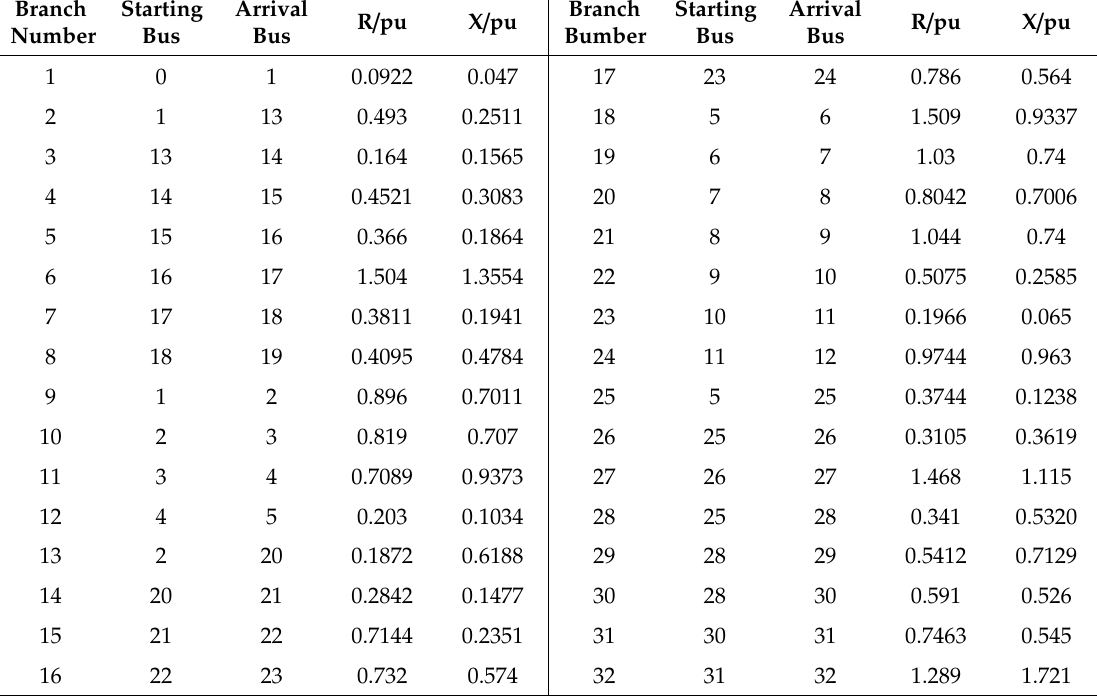
Table A1. The resistance parameters of the IEEE33